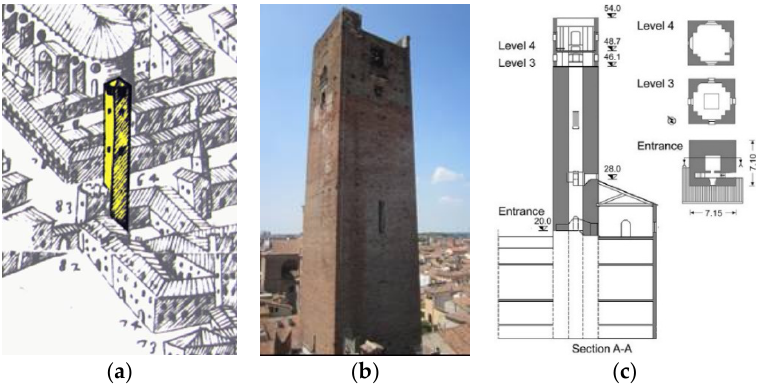
Figure 1. The Gabbia tower in Mantua, Italy: ( a ) view from the 17th century [4]; ( b ) recent view from the east; and ( c ) section of the tower (dimensions in m).